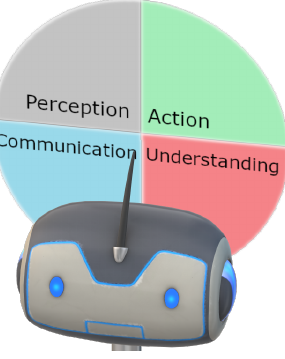
Figure 2. Four basic functions of domestic